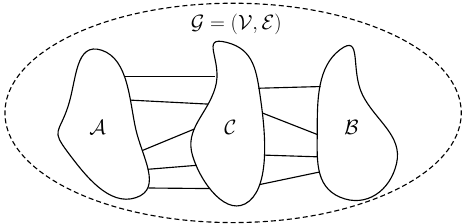
Figure 1. Illustration of a vertex separator. The vertex set and are disconnected, while minimizing the size of B of vertices) between